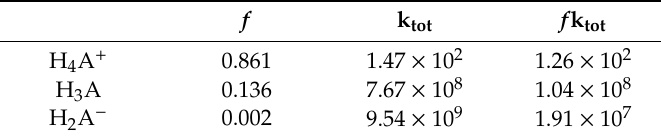
Table 4. Molar fractions ( f ), total rate constants (k tot , M − 1 s − 1 ), and corrected-by-fraction total